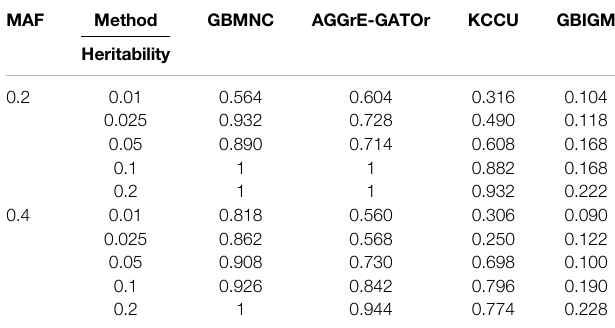
TABLE 2 | Type-I error for KCCU, GBIGM, AGGrEGATOr, and GBMNC when varying the sample size from 1,000 to 5,000. Methods Sample size